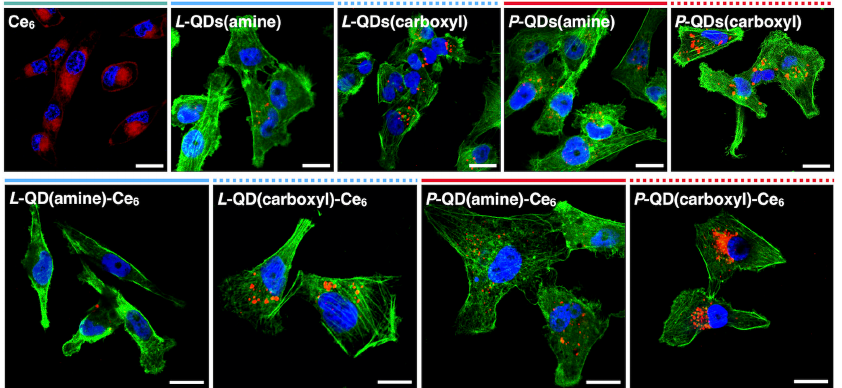
Figure 5. Accumulation of Ce 6 , QDs with various surface coatings, and their respective complexes in MDA-MB-231 breast cancer cells. Red – Ce 6 (in the Ce 6 image) or QDs (in all the QD and QD-Ce 6 images); green – actin filaments; blue – nuclei. Scale bars in all images are 20 µm.